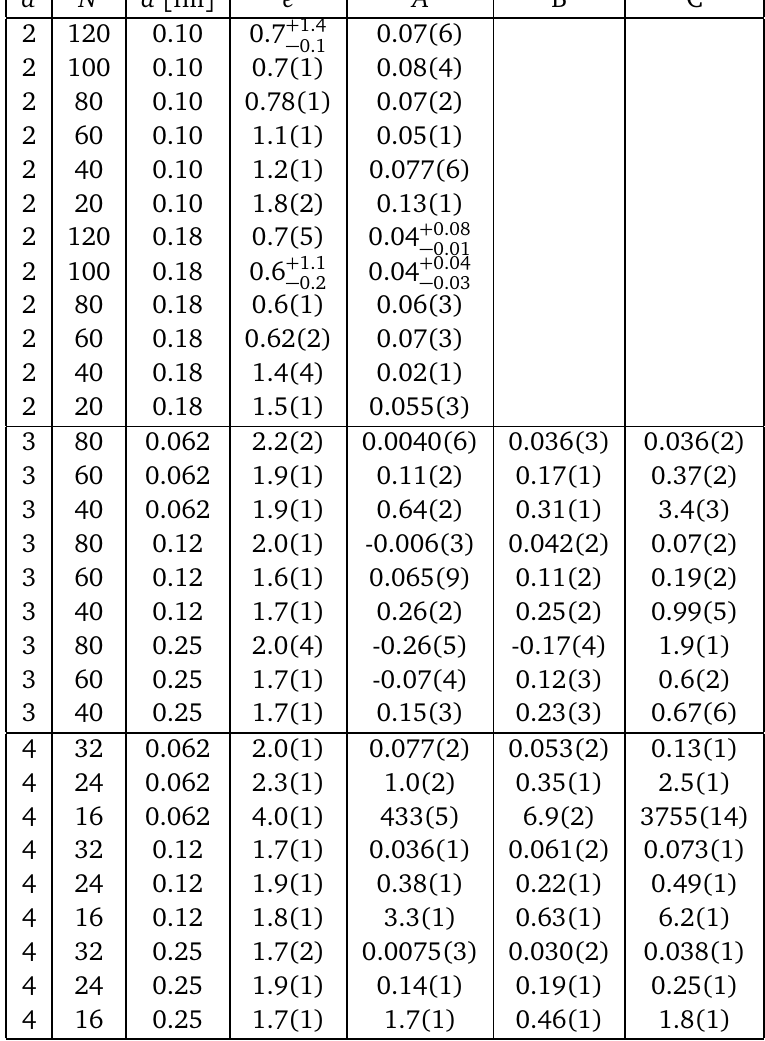
Table 2: The fit parameters of the fits (6) and (7) in two, three, and four dimensions, respectively. Note that no dimensions are given for A , B , and C , as to suppress error propagation due to e , the propagators have been made initially dimensionless by rescaling with 1 GeV. If desired, the results can be reconverted in a straightforward